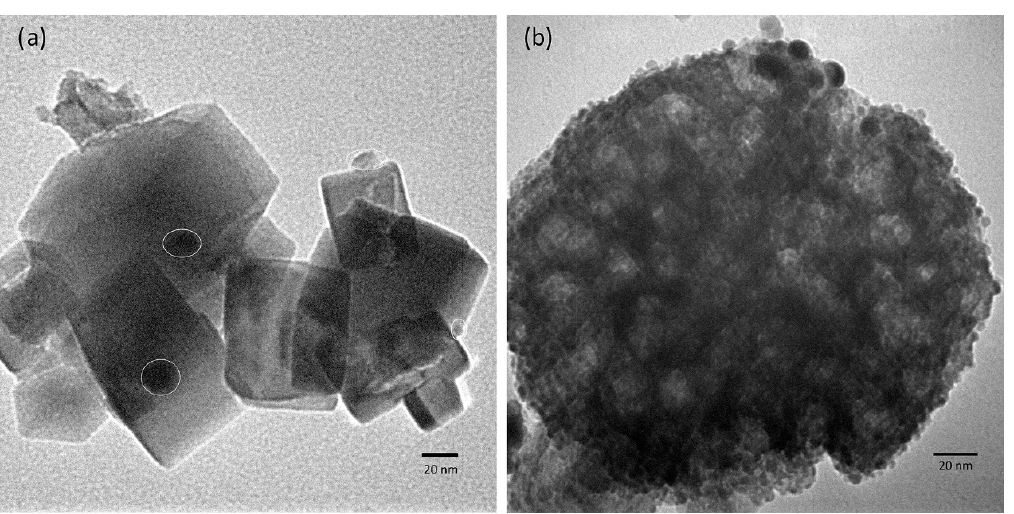
Fig. 4 TEM images of Rh-doped SrTiO 3 catalysts with Ru cocatalysts ( a ) Ru/MW-STO2Rh-A ( b ) Ru/MW-STO2Rh-T. ( b ) Ru/MW-STO2Rh-T.